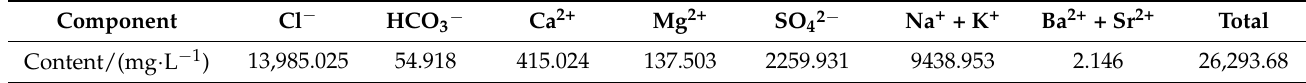
Table 1. The ion composition of formation water in oil reservoirs.